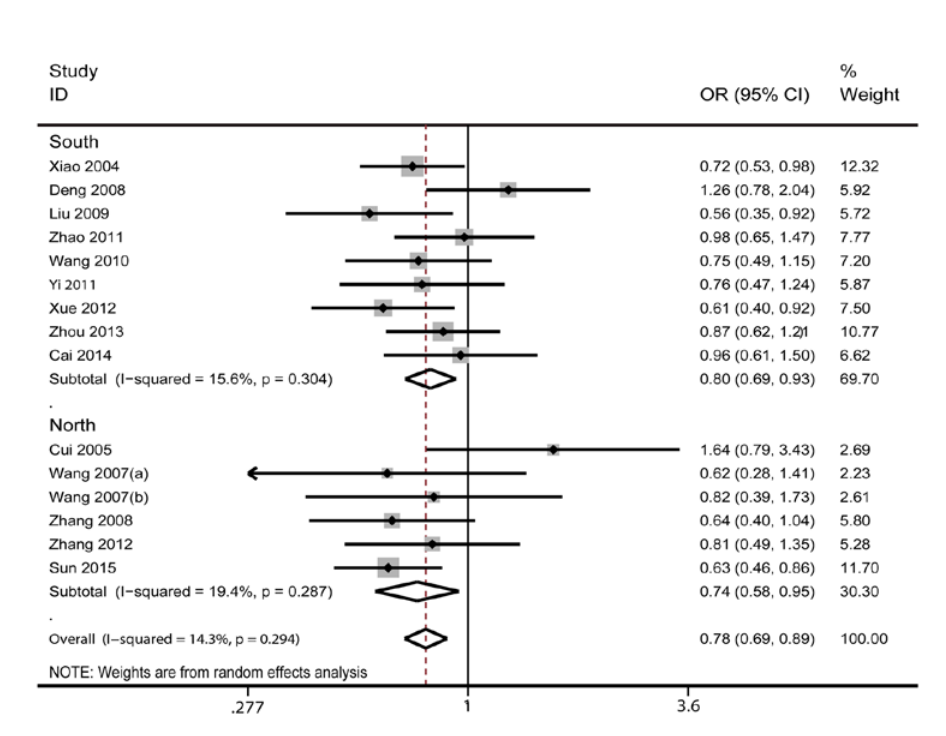
Figure 2: Forest plot of ORs for the association between ABCA1 R219K and ischemic stroke risk under the dominant model (KK+RK vs. RR, stratified by population region). The circle and horizontal lines represent the OR and 95 % CI and the area of the squares reflect the weight of individual studies included in the meta-analysis. The diamonds represent the pooled ORs and 95 %